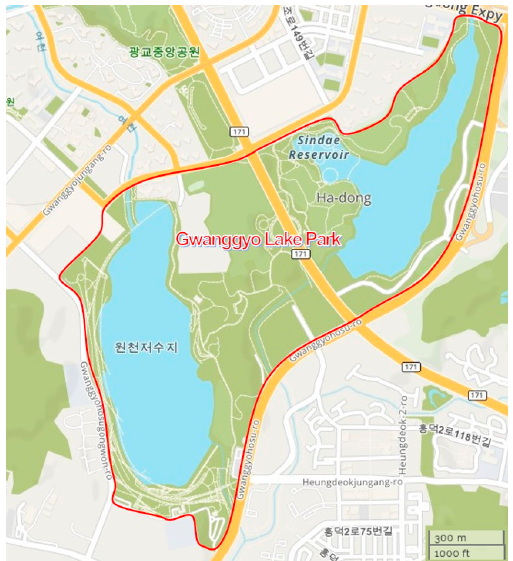
Figure 1. Map of Gwanggyo Lake Park.